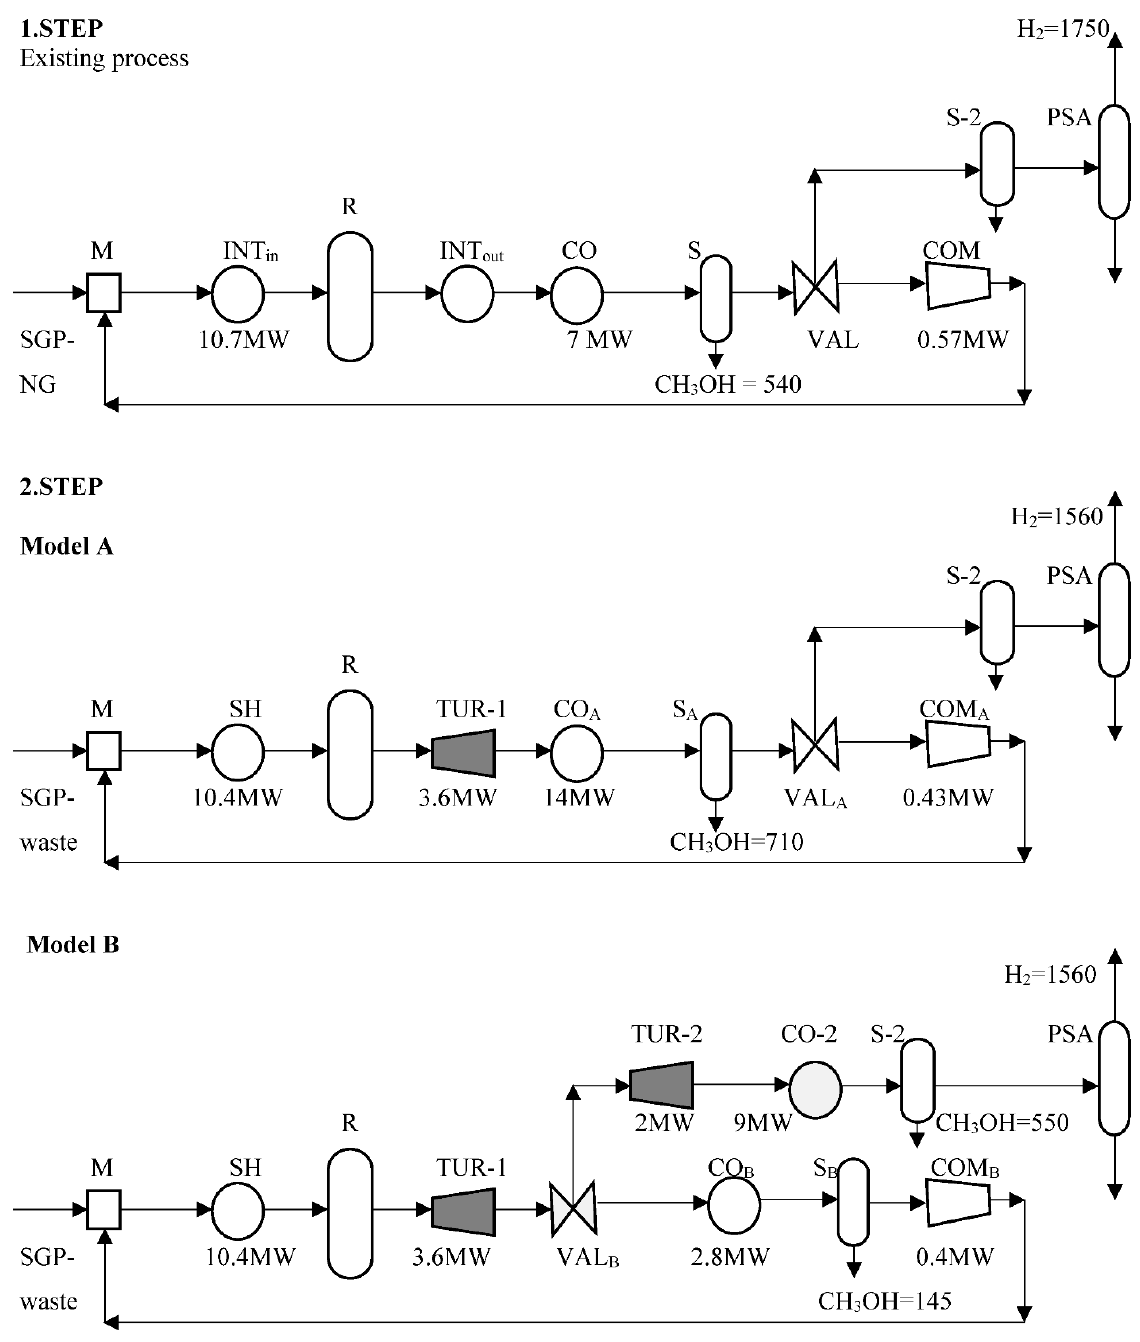
Figure 2. Flow diagram of the upgraded electricity cogeneration technique of the case study. In the second step, conventional natural gas could be replaced with waste as raw materials by using the same simulated model from the first step. The natural gas was replaced with waste, such as otherwise useless polyethylene waste (PEW), which was separated from municipal solid waste (MSW), gasified, and reformed ([33]; reaction Re5; F C2H4,in = 1000 kmol/h; F H2O,in,Re5 = 2000 kmol/h), and purified flue gas (without parti- cles, NO x , SO x , and nitrogen; F CO2,in = 240 kmol/h; F H2O,in = 920 kmol/h). Nitrogen ( F N2,in = 2800 kmol/h) from flue gas was separated for ammonia